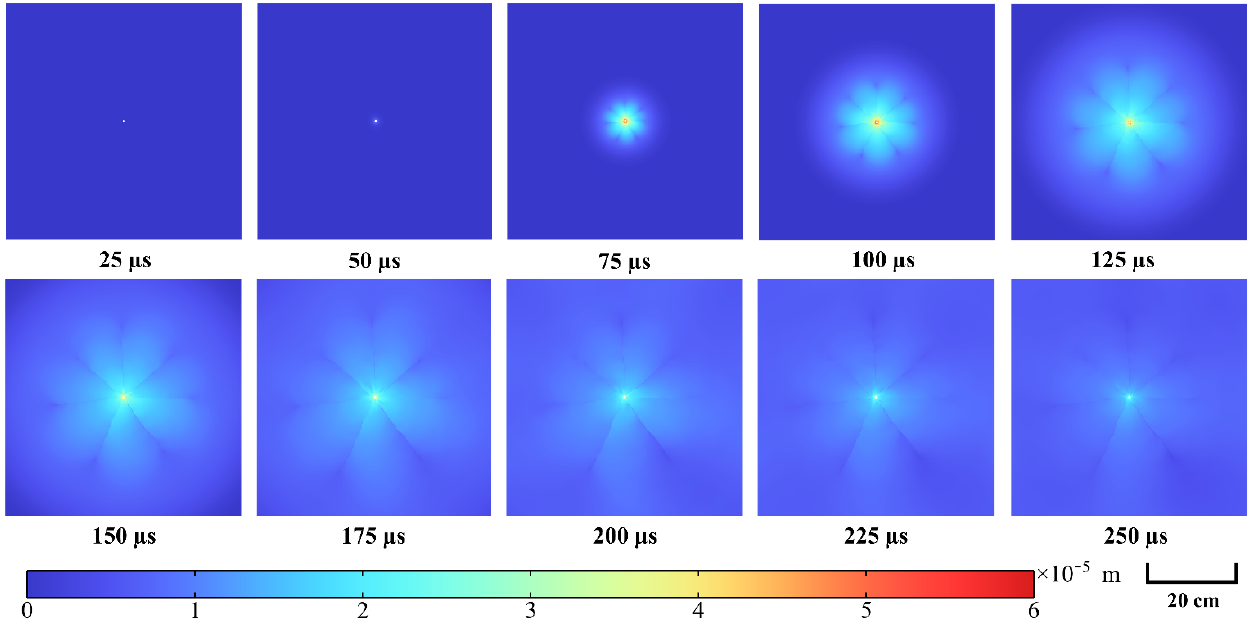
Figure 19. Cloud diagrams of development of granite displacement under high–voltage electropulse at different time.